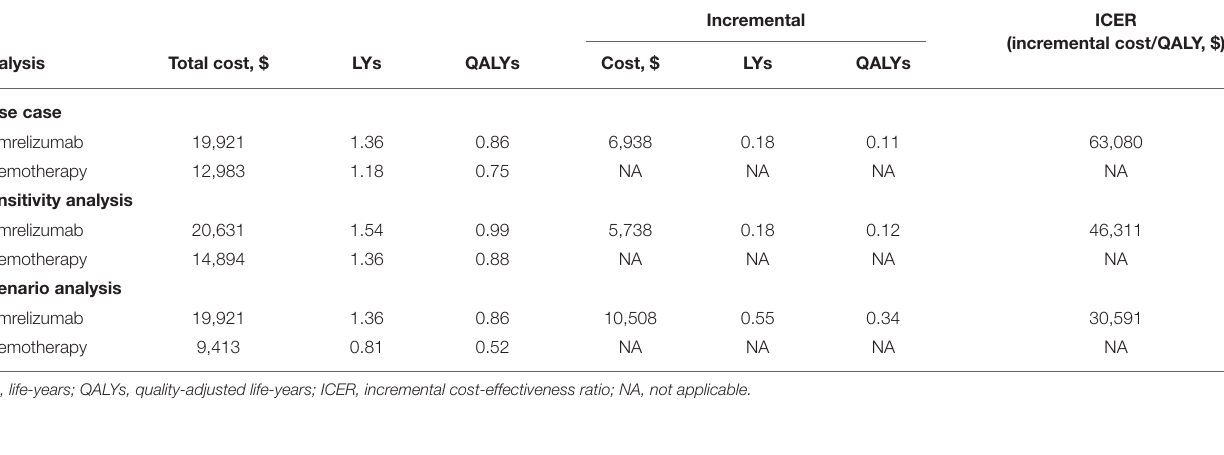
TABLE 2 | Discounted incremental cost-effectiveness of camrelizumab.